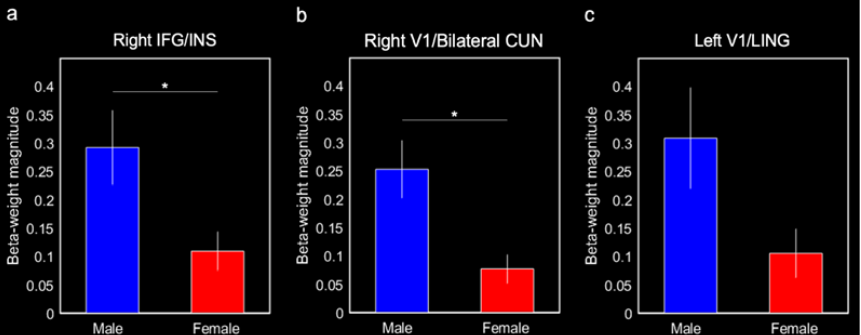
Figure 5. Mean beta-weight magnitudes extracted from three ROIs identified in the group entorhinal cortex connectivity results for males and females. Mean beta-weight magnitudes represent connectivity between the entorhinal cortex and ( a ) right IFG and insula (INS), ( b ) right V1 and cuneus (CUN), and ( c ) left V1 and lingual gyrus (LING). Error bars represent ± 1 standard error of the mean. * Bonferroni-corrected p < 0.05.